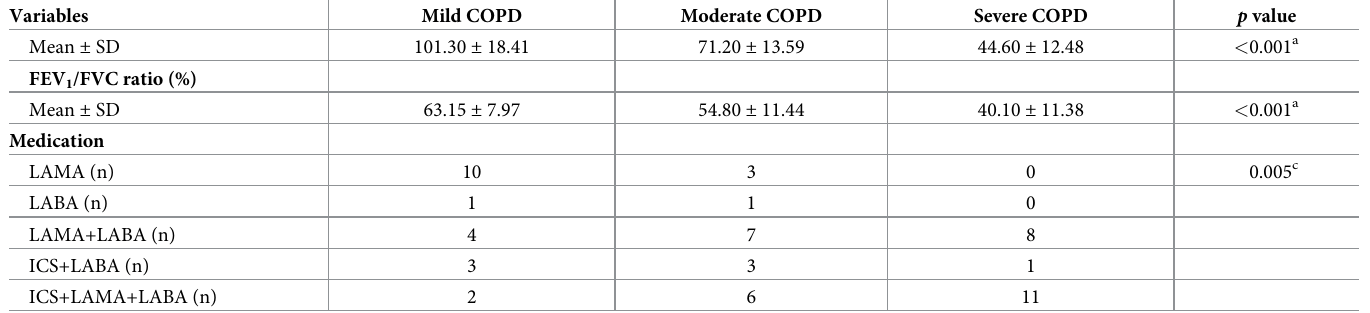
the names of the five genera and the Y-axis the relative abundance of each. We found four gen- era, including Veillonella , Corynebacterium 1, Romboutsia , and Aerococcus , that are more abundant in group C than groups A and B. Megasphaera was found at lower abundance in group A than groups B and C. The statistical significance may due to few outliers. OTU abundance correlated with blood eosinophil percentage and lung function Correlation analysis revealed that some OTUs are associated with clinical features (Fig 6). OTU 19 ( Bacteroides sp.) had a stronger negative correlation with eosinophil count